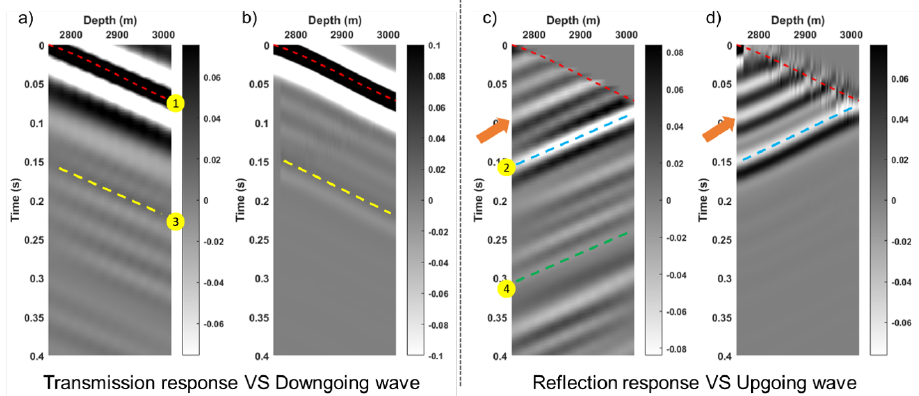
Figure 15. Interferometry using check shot data for a virtual source at the top geophone. ( a , b ) show the estimated transmission response and the actual downgoing wave from the model. ( c , d ) show the estimated reflection response and the actual upgoing wave from the model. The up- and downgoing wavefield synthetic response is generated from the same truncated model as in Figures 11b and 12b, except now using an 18-Hz peak frequency wavelet.